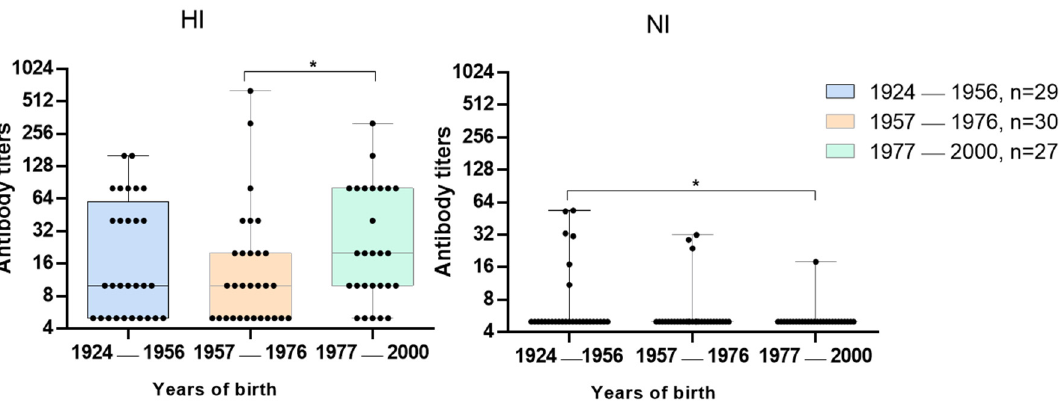
Figure 3. Serum antibody titers to the HA and NA of A/Hong Kong/4801/2014(H3N2) strain in healthy persons in 2017–2018 flu season, * p < 0.05.